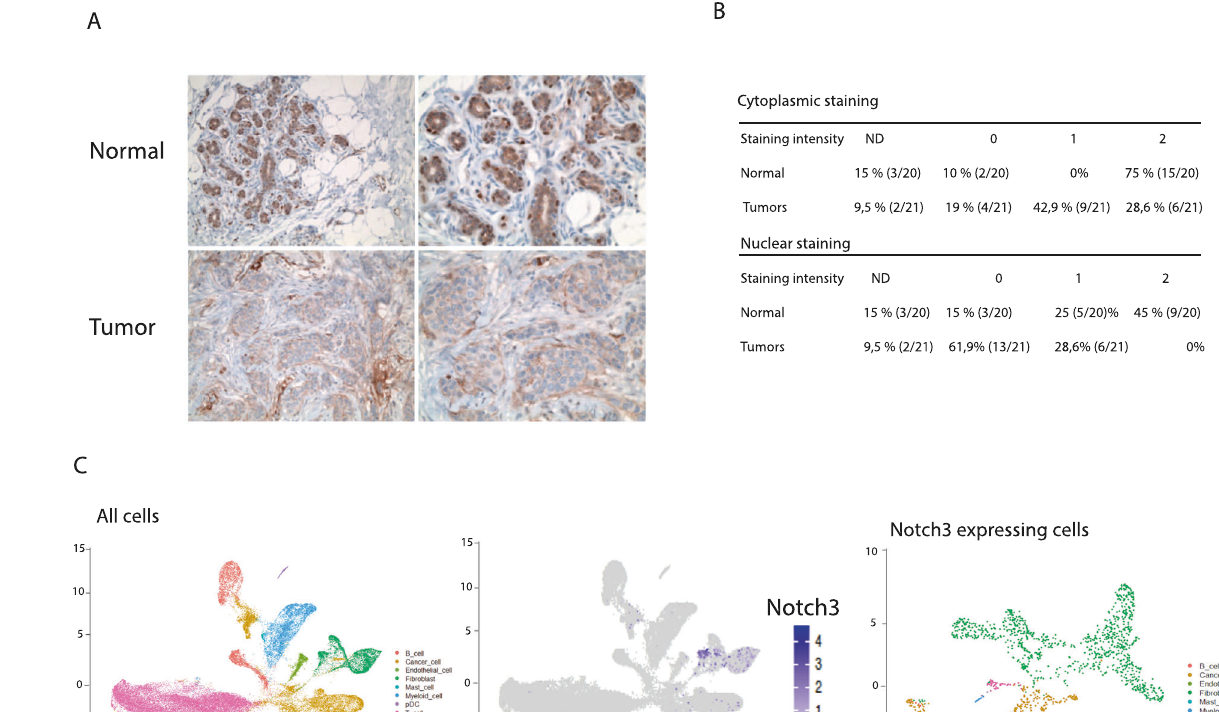
Cell Death and Disease (2023)